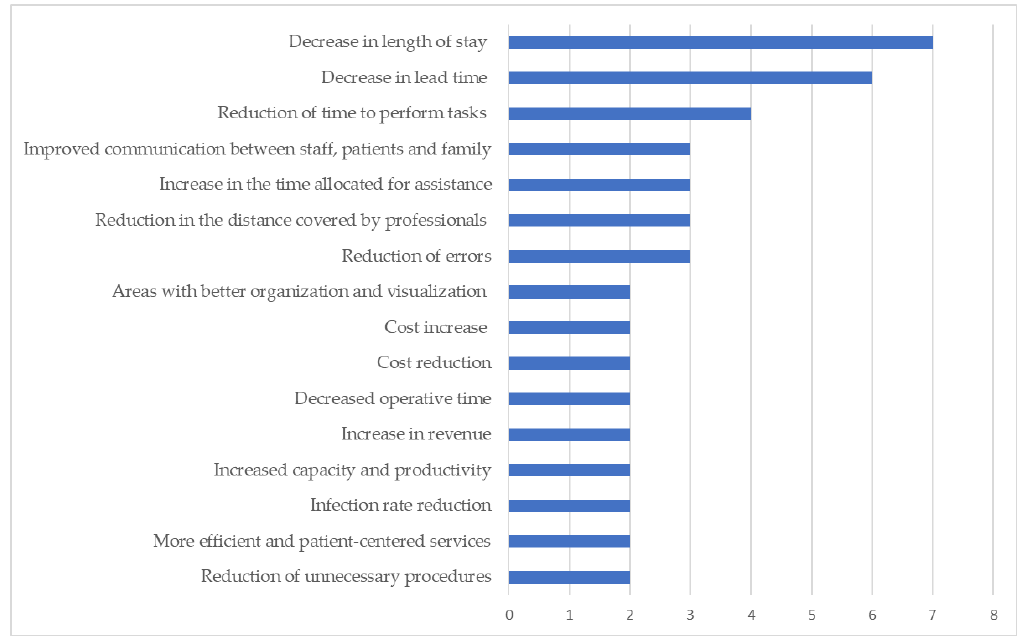
Figure 7. Graph of the main results obtained from the included studies.